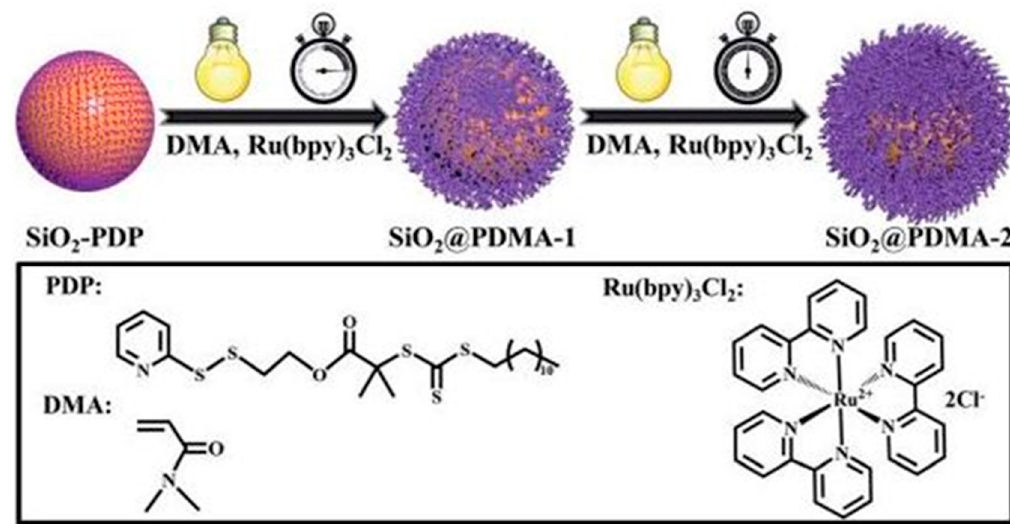
Figure 8. Surface-initiated PET–RAFT polymerization of DMA monomers from SiO 2 -PDP nanoparticles in acetonitrile, with prior deoxygenation at 25 °C under blue LED light irradiation [66].